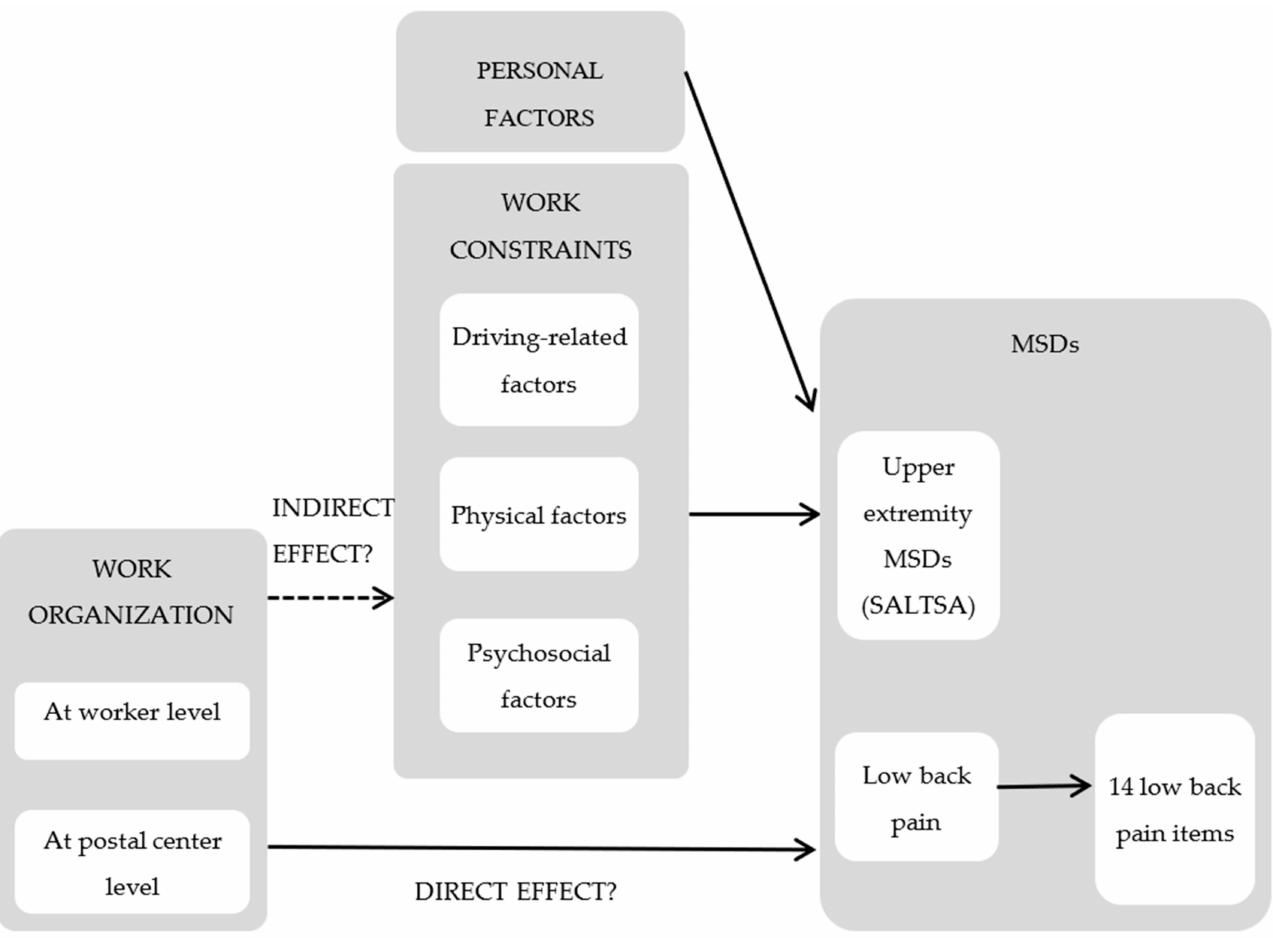
Figure 1. Frame model of the relationships between work situation (work constraints and organi- zation) and musculoskeletal disorders (MSDs) while using light-duty vehicles for delivering mail and